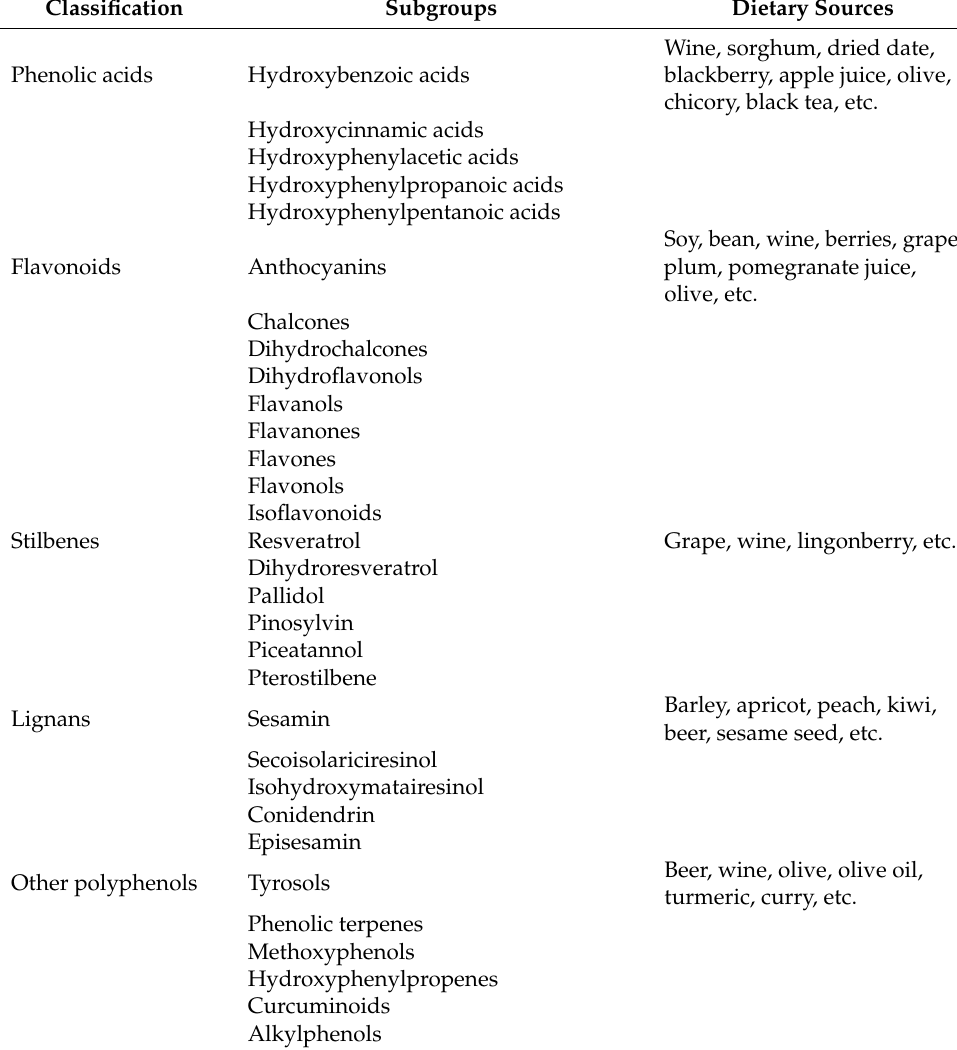
Table 1. Classification of polyphenols and dietary